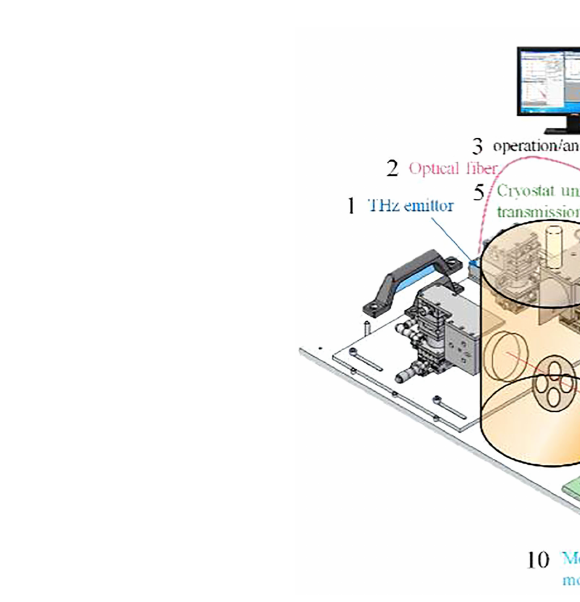
FIGURE 1 The structure and working principle of the Advantest-TS7400 THz-TDS measurement